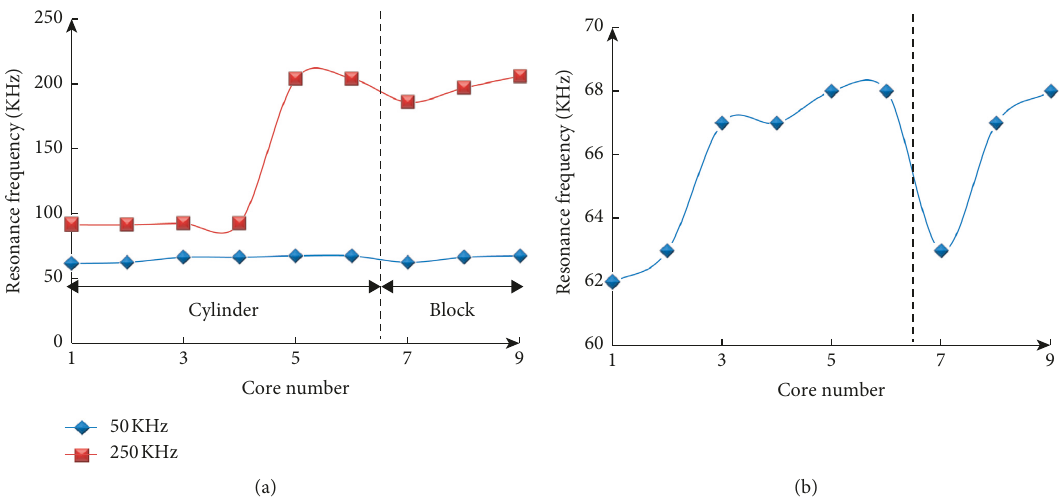
Figure 12: Resonance frequencies curves of sandstone cores under the different excitation frequencies: (a) the excitation frequency of 50kHz and 250kHz; (b) the excitation frequency of 50kHz.